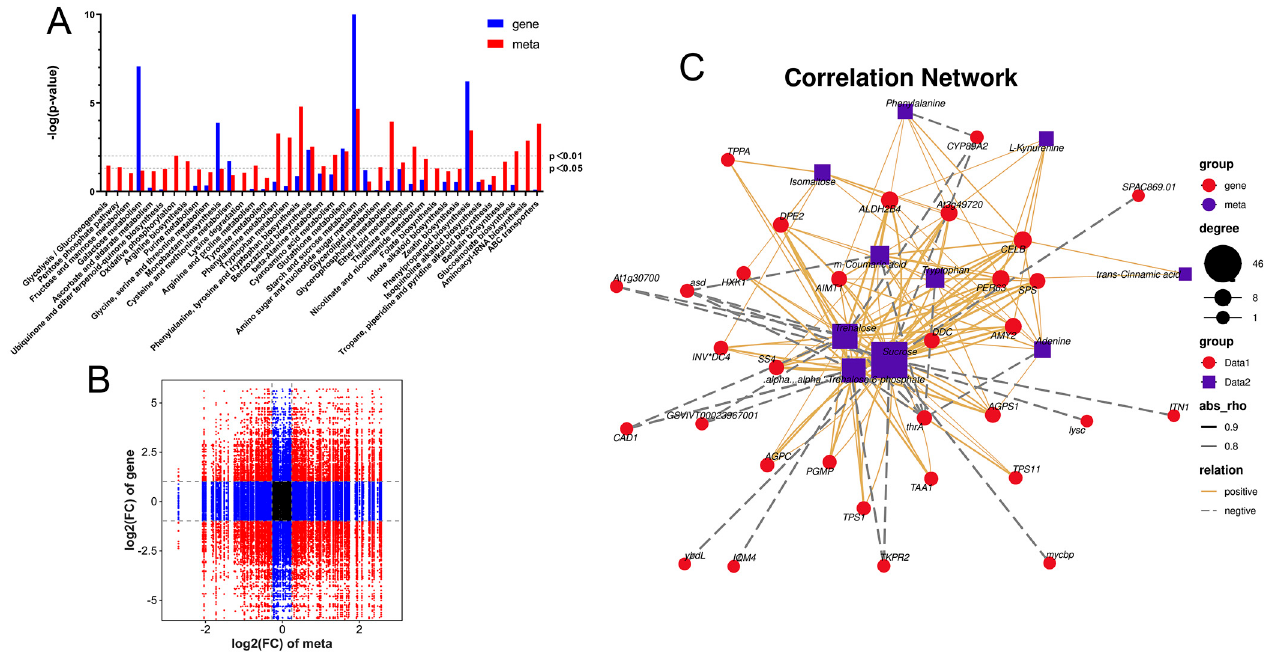
Figure 7. Correlation analysis of differential genes and differential metabolites in F-CG and CF-CG. ( A ): The nine-quadrant diagram shows the correlation of differential genes and differential accumulation metabolites between F-CG and CF-CG; ( B ): KEGG co-enrichment analysis of differential genes (blue column) and differential metabolites (red column); ( C ): correlation network diagram of differential genes and differential metabolites in pathways related to taproot enlargement in garden ginseng.